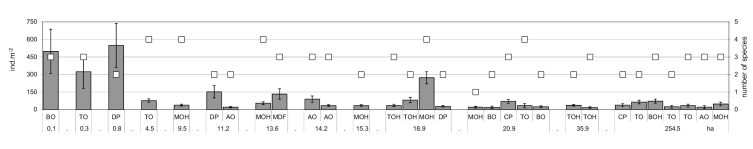
Total population densities (ind.m-2 ± SE) (columns) and numbers of species (white squares) in the isopod assemblages at the sites sampled in the different fragments of woodland.